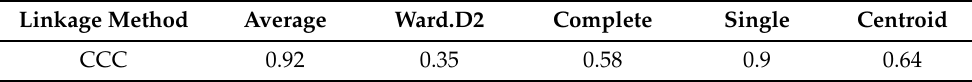
Table 2. Cophenetic Correlation Coefficient (CCC) corresponding to the various